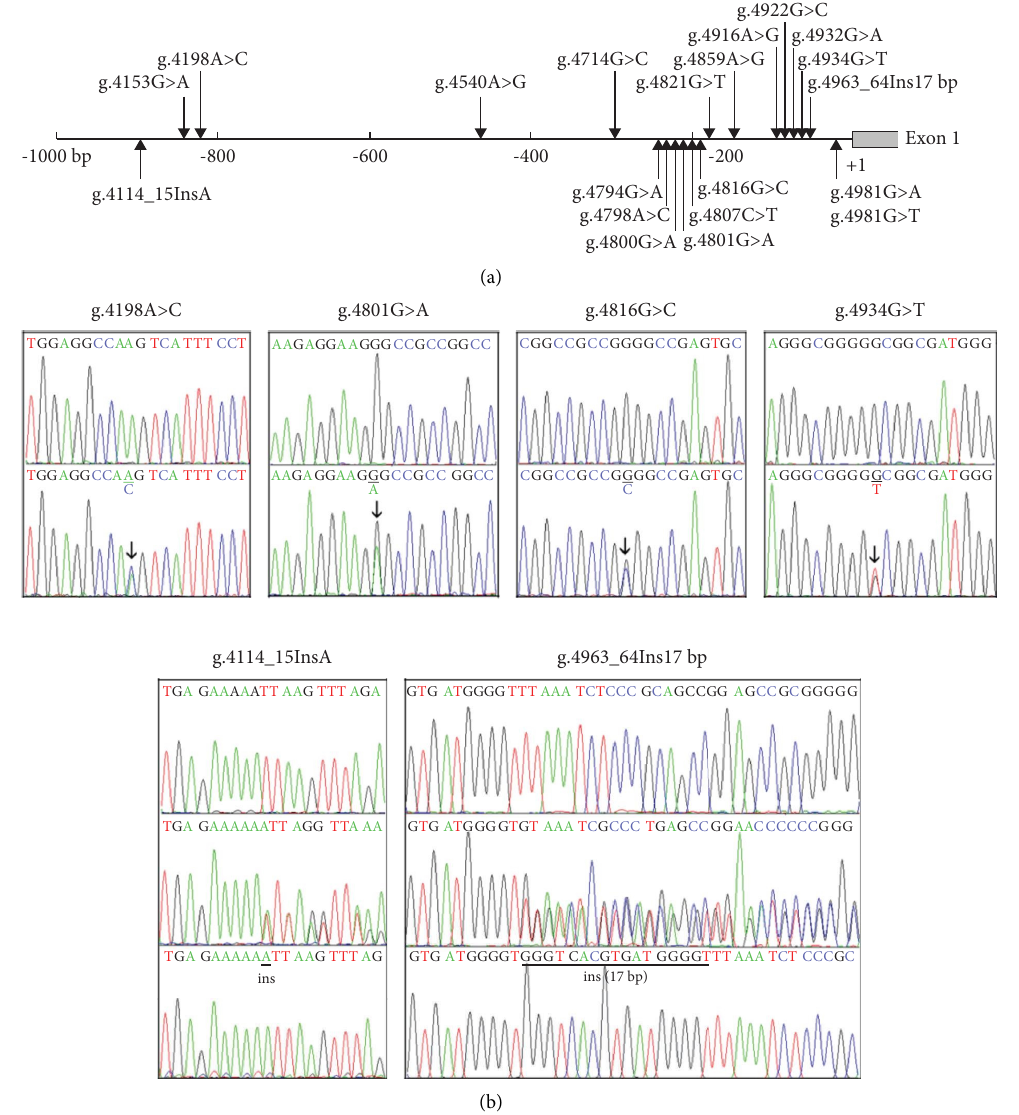
Figure 1: Genetic variants within the SIRT1 gene promoter in T2D patients and controls. (a) Schematic representation of the genetic variants in the SIRT1 gene promoter. Te numbers represent the sequences of SIRT1gene promoter (Genbank accession number NG_050664.1). Te transcription start site is at the position of 5008 of the frst exon. (b) Sequencing chromatograms of the genetic variants which were only identifed in T2D patients. Tese genetic variants were depicted in forward orientations. For genetic variants g.4198A > C (rs35706870), g.4801G > A, g.4816G > C, and g.4934G > T, top panels show the sequencing of wild type and bottom panels show the sequencing of heterozygous variants. For the insertion genetic variants, g.4114-15InsA and g.4963_64Ins17bp, top panels show the se- quences of wild type, and middle panels show the sequences of heterozygous variants. To examine the exact insertion sequences, the SIRT1 gene promoter containing insertion genetic variants are subcloned into T-vectors, and then directly sequenced. Te insertion sequences are shown in bottom panels. Heterozygous genetic variants are marked with solid arrows and the sequences of insertion genetic variants are